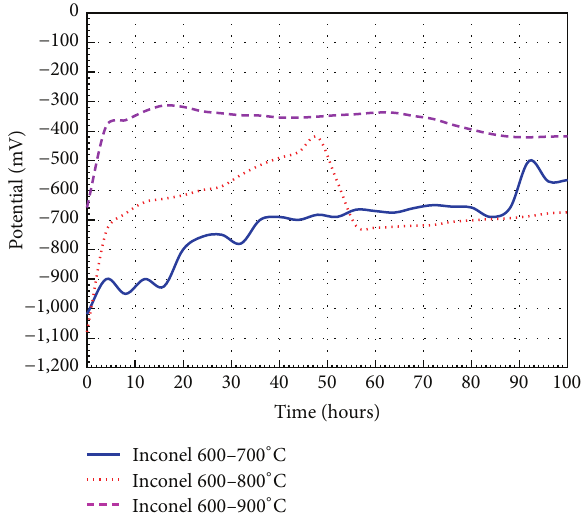
Figure 2: Progress of 𝐸 values with testing time for Inconel 600 corr in NaCl-KCl at the different temperatures.